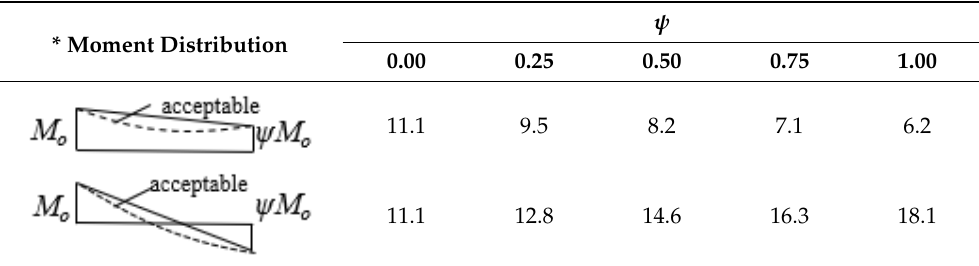
Table 4. C dist coefficient for continuous beams without loading on the analyzed span ( L ). Adapted from ABNT NBR 8800:2008 [108] .